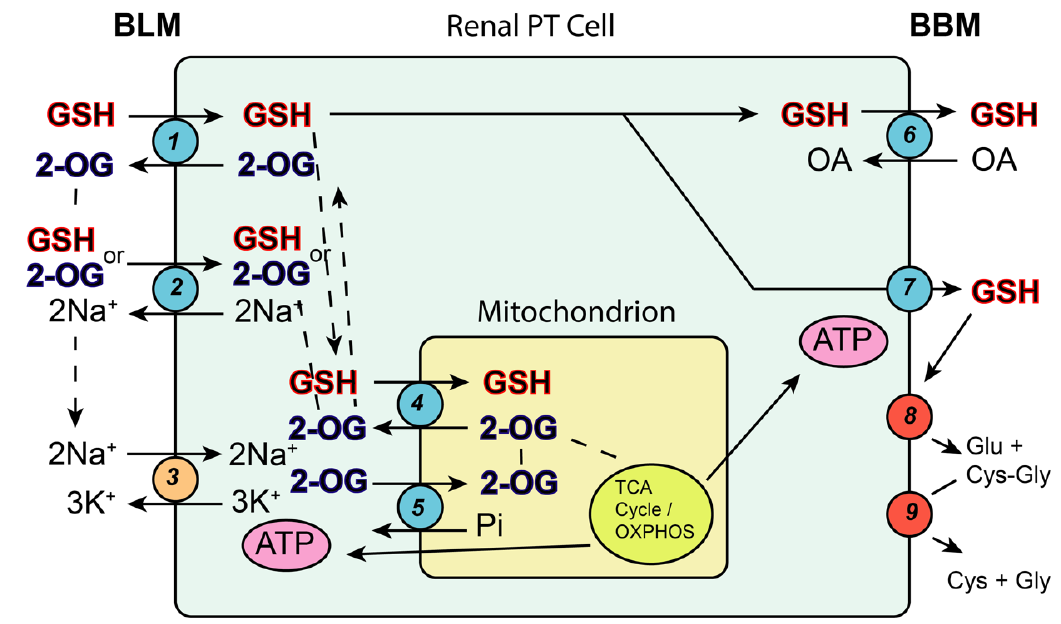
Figure 6. Pathways of plasma membrane and mitochondrial GSH transport in the renal PT cell. The scheme shows the major membrane carriers for GSH on the mitochondrial inner membrane and on the basolateral membrane (BLM) and the brush-border membrane (BBM). The integration of these carriers with a supply of 2-oxoglutarate and a supply of ATP and Na + ion gradients is highlighted with dashed lines. A critical role for mitochondrial energetics, which supplies the PT cell with ATP via the tricarboxylic acid (TCA) cycle and oxidative phosphorylation (OXPHOS), is also evident. Processes and their functions: (1) Organic anion transporter 1 or 3 (Oat1/3; Slc22a6/8 ): transports GSH in exchange for 2-OG at the BLM; (2) sodium-dicarboxylate carrier (NaC3; Slc13a3 ): transports 2-OG in exchange for 2 Na + ions at the BLM and provides 2-OG for Oat1/3; (3) (Na + + K + )-ATPase: establishes Na + and K + ion gradients across the BLM and provides Na + as a driving force for many Na + -coupled transporters; (4) 2-oxoglutarate carrier (OGC; Slc25a11 ): transports GSH in exchange for 2-OG across the mitochondrial inner membrane; (5) dicarboxylate carrier (DIC; Slc25a10 ): transports either 2-OG or GSH in exchange for inorganic phosphate (Pi) across the mitochondrial inner membrane; (6) organic anion transporting polypeptide 1a1 (Oatp1a1; Slco1a1 ): transports GSH across the BBM and into the tubular lumen in exchange for various organic anions (OA); (7) multidrug resistance protein 2/4 (Mrp2/4; Abcc2/4 ): primary active transporters (ATP-dependent) that catalyze efflux of GSH across the BBM and into the tubular lumen; (8) γ -glutamyltransferase (GGT): enzyme on BBM that cleave the γ -glutamyl residue from GSH; (9) cysteinylglycine dipeptidase (DP): enzyme on BBM that cleaves L-Cys-Gly into constituent amino